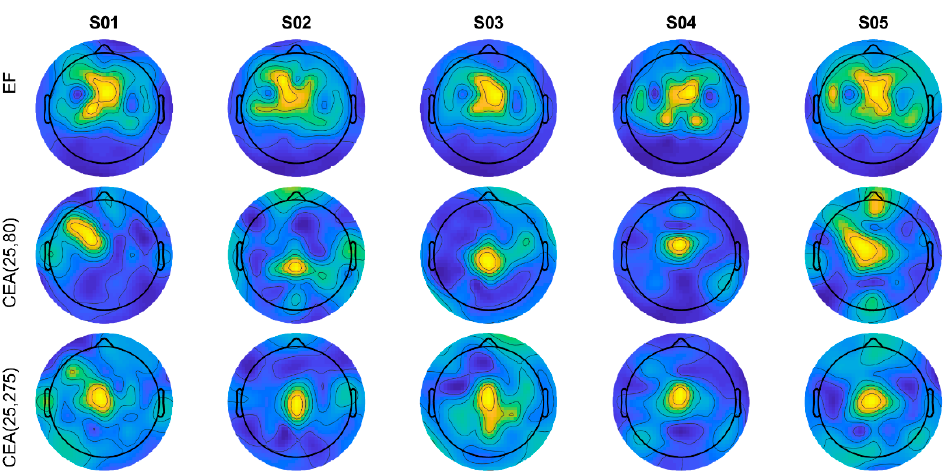
Figure 3. Topographic plots of the E-field, and CEA(25,80) and CEA(25,275) (rows) for all subjects (columns), as indicated on the top and left.